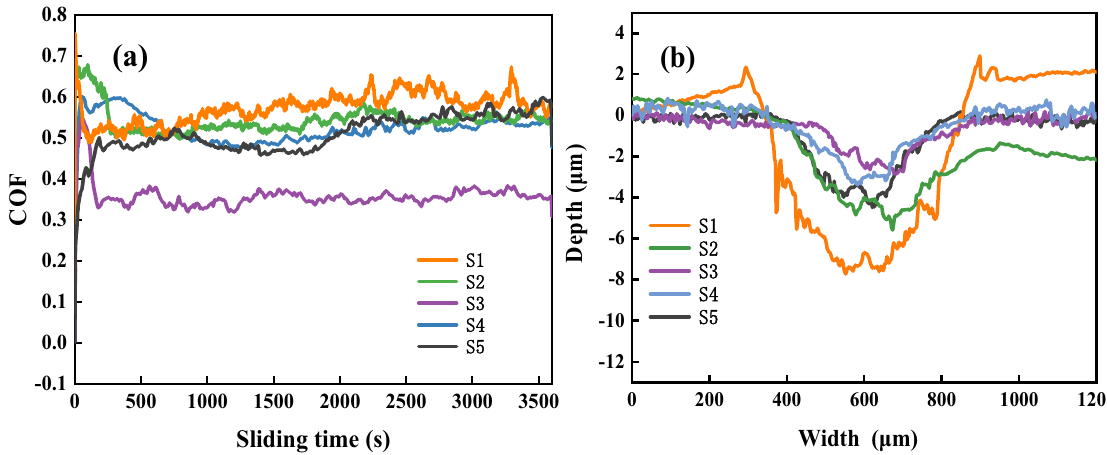
Figure 12: ( a ) Fiction coe ffi cients of S1 – S5 coatings in dry friction environment; ( b ) 2D contour map of S1 – S5 coatings in dry friction